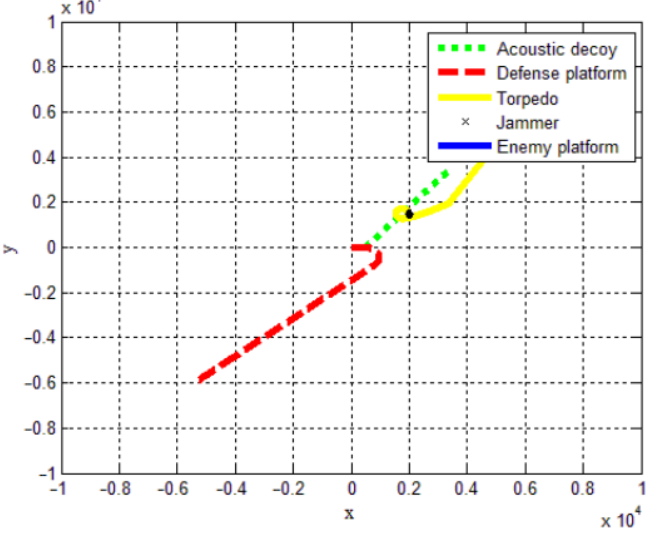
Figure 12. The simulation of the optimal warfare strategy.